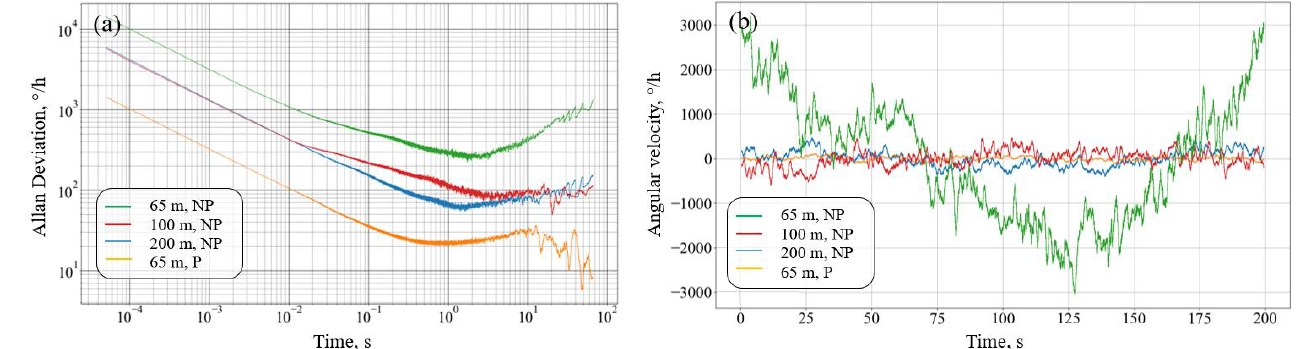
with a time window of 1 s.